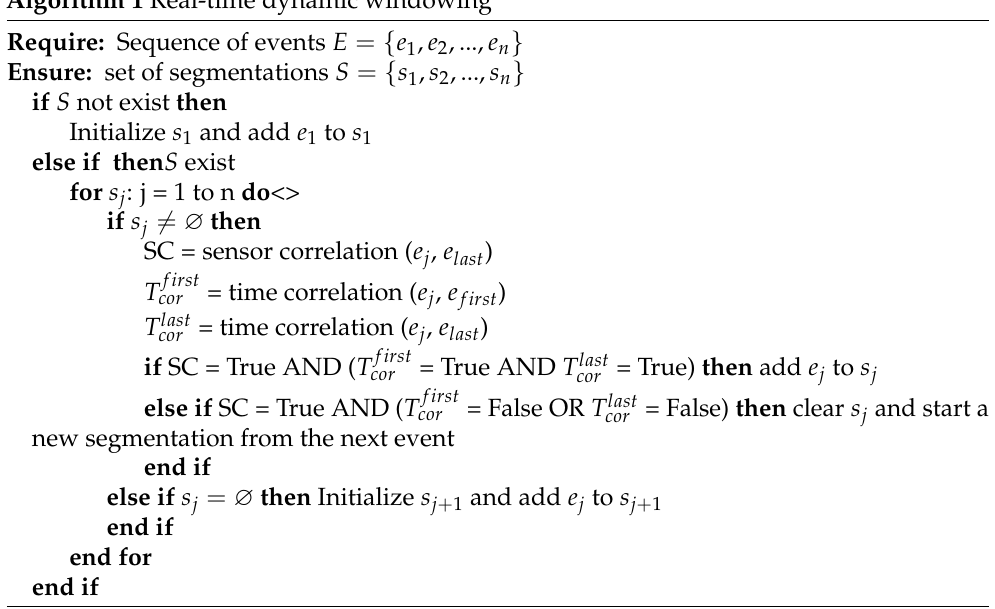
Algorithm 1 Real-time dynamic